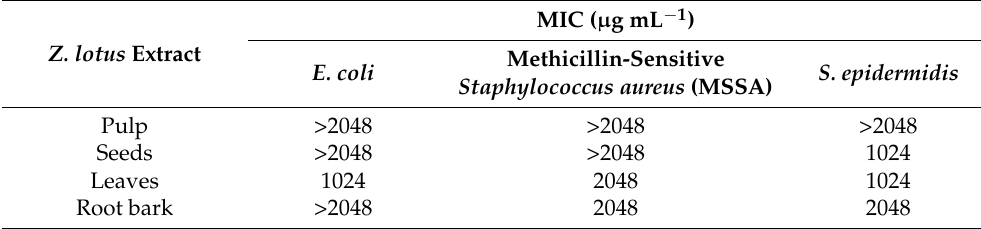
Table 3. MIC values of lipophilic Z. lotus extracts against E. coli , MSSA and S. epidermidis , determined through Resazurin